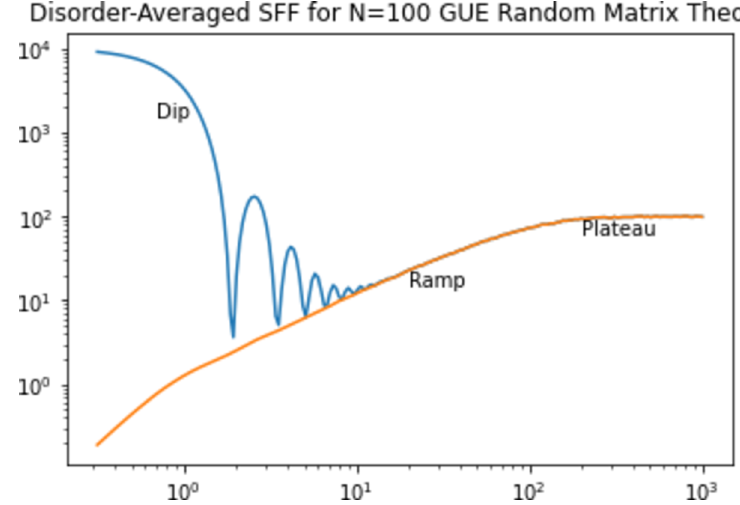
Figure 1 . Full (blue) and connected (orange) SFF for GUE random matrix theory on a log-log